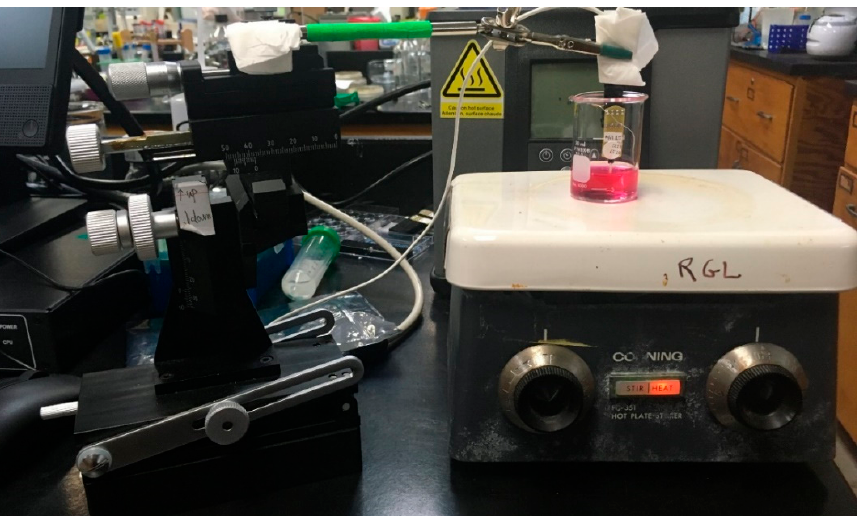
Figure 3. Experimental setup of the probe during calibration. The magnetic stirrer ensured a continuous steady flow of H 2 O 2 to the electrode surface.